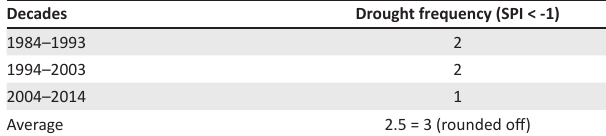
TABLE 3: Non-parametric homogeneity test (Pettitt’s test). Pettitt’s test (26,3)